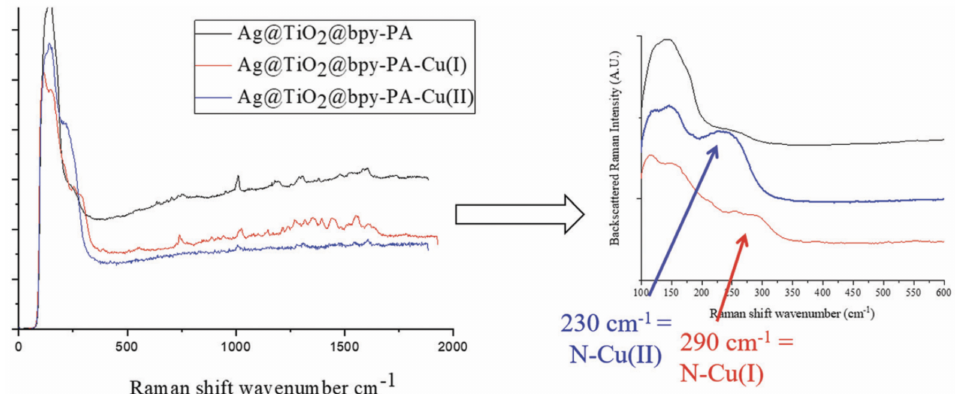
Figure 8. SHINERS spectra for Ag@TiO 2 @bpy-PA (in black), Ag@TiO 2 @bpy-PA-Cu(I) (in red) and Ag@TiO 2 @bpy-PA-Cu(II) (in blue), where the Raman peaks of N-Cu(II) and N-Cu(I) vibrational modes are depicted. The figure is reproduced from [105] with permission from the Royal Society of Chemistry, Copyright